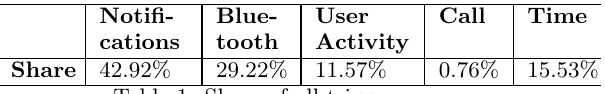
Table 1: Share of all trigger